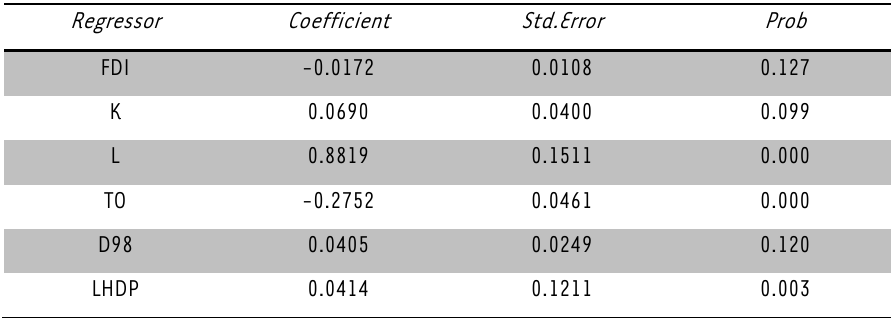
TABLE A1: Estimated Long-Run Coefficients using the ARDL Approach Dependent variable is Y